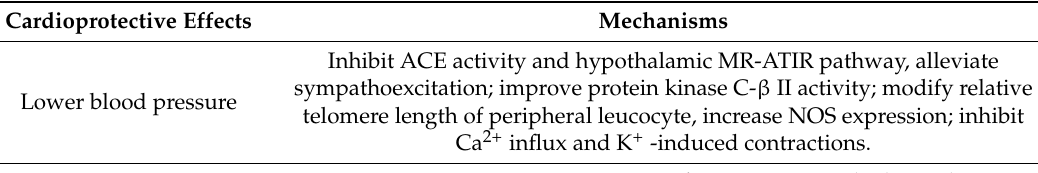
Table 3. The mechanisms involved in the cardioprotective effects of